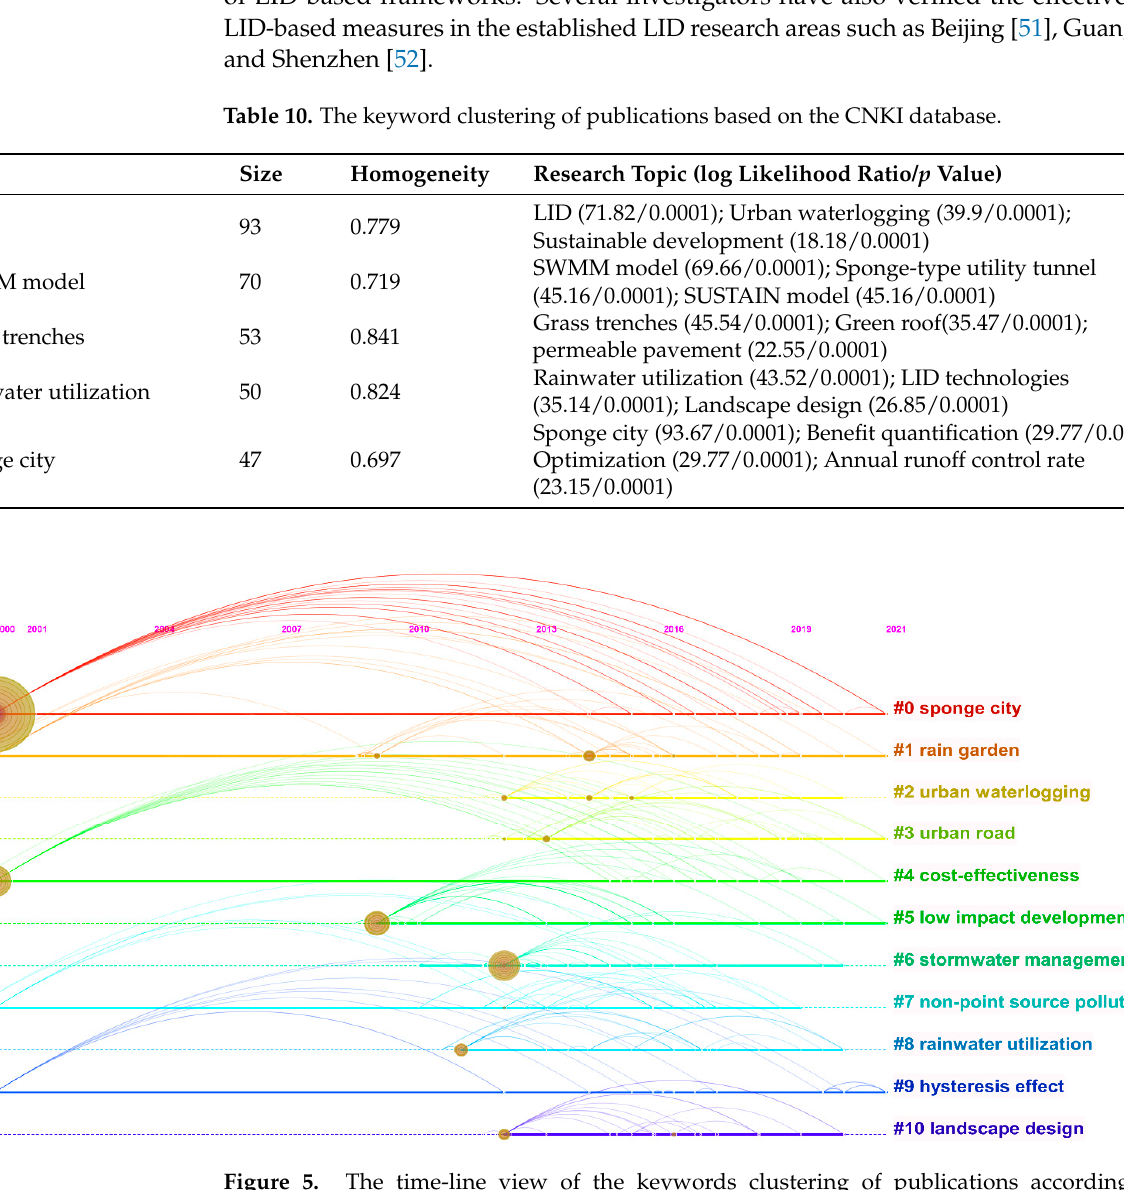
Figure 5. The time-line view of the keywords clustering of publications according to the CNKI database. Table 10. The keyword clustering of publications based on the CNKI database.